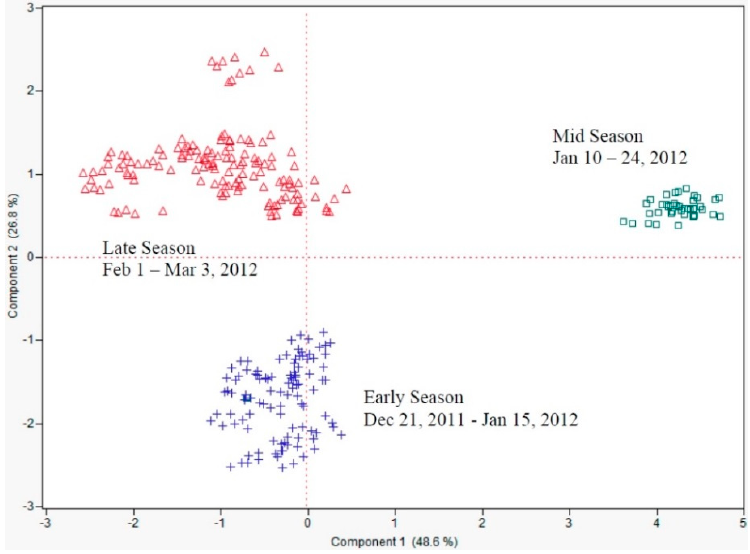
Figure 5. Principal components analysis showing e-tongue separation (sensor set #5) of Hamlin orange juice from fruit harvested over the season (early, mid and late harvests) for the 2011–2012 season in South Florida.